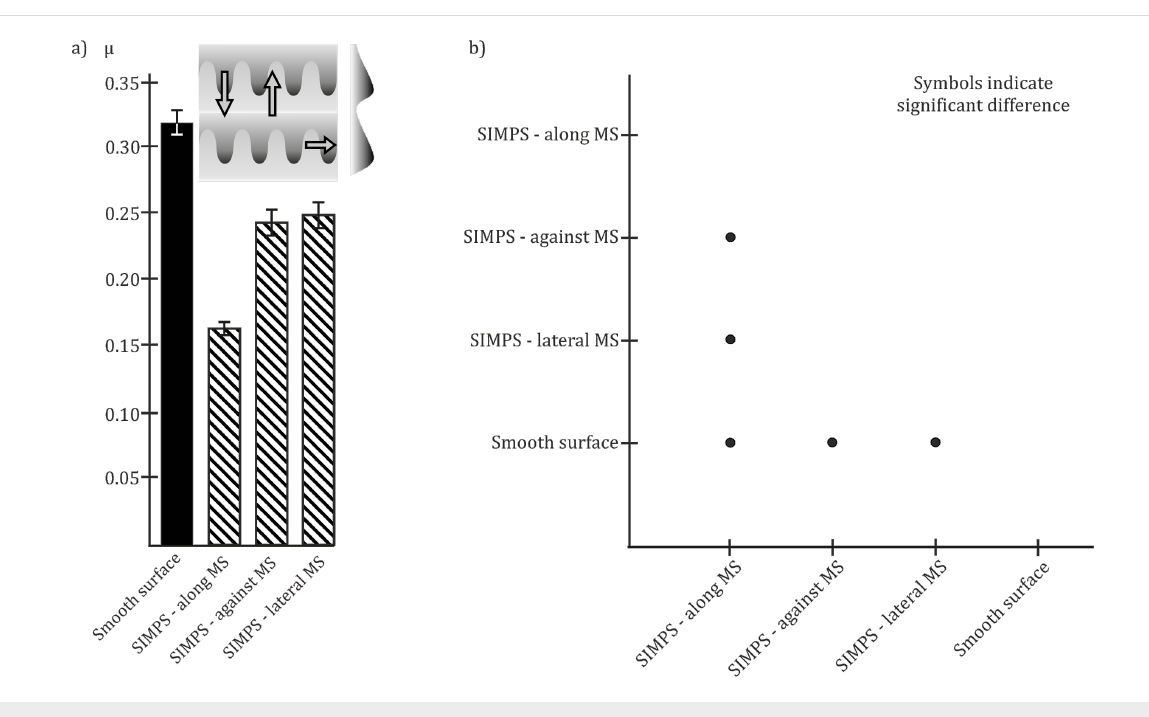
Figure 8: a) Results of tribological measurements of SIMPS in contact with a glass ball. Black column: smooth surface as reference. Hatched columns: SIMPS. To investigate the influence of the anisotropic geometry of the microstructure on frictional properties, measurements were performed in three different sliding directions. MS: microstructure. Average frictional coefficients (µ) and standard deviations are shown. b) Multiple comparison graph of the results presented in a). The dots indicate statistically significant differences between